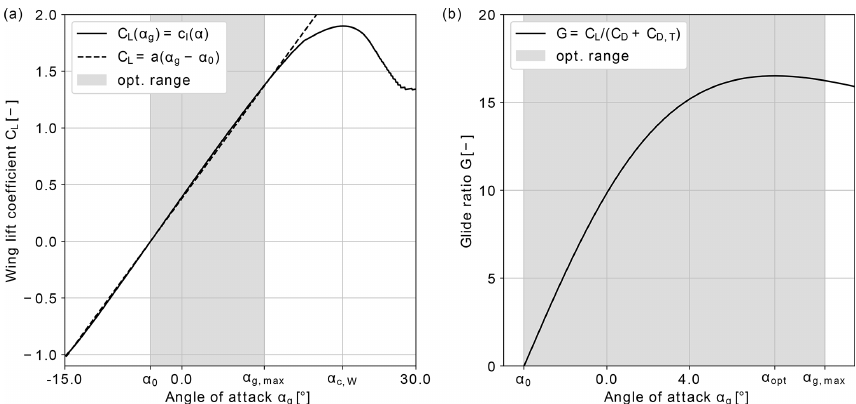
Figure 5. Aerodynamic quantities of the finite wing with aspect ratio AR = 12: (a) wing lift coefficient and (b) glide ratio. The shaded area shows the optimisation range of the optimal control problems (Eqs. 33 and 36) in between the zero-lift angle of attack of the airfoil α L = 0 ≈ − 4 . 0 ◦ and the maximal value α max ≈ 10 . 6 ◦ of the validity range of linear approximation (Eq. 37). The critical angle of attack of the wing is α c , W ≈ 20 . 6 ◦ , and the angle of attack corresponding to the maximal value of the glide ratio is α opt ≈ 8 . 1 ◦ .